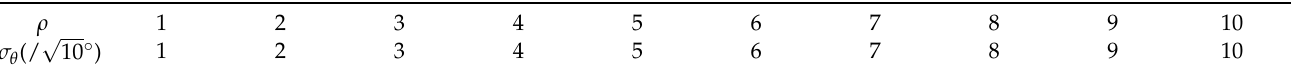
Table 8. Standard deviation σ θ against ρ at V = 0.2 m/s.